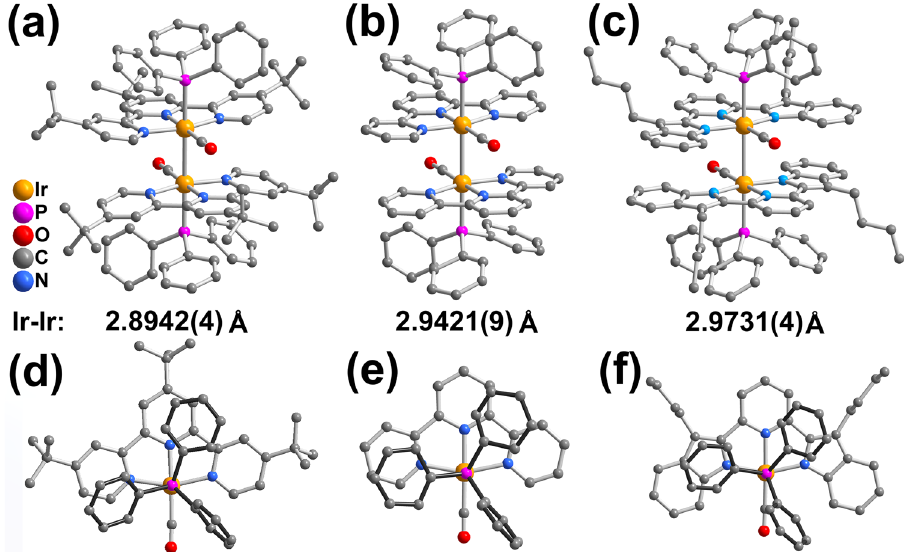
Fig. 3 X-ray crystal structures of 1 – 3. Complex cations of 1 – 3 ( a – c ) and their corresponding half fragments from top view ( d – f ). Hydrogen atoms and solvent molecules are omitted for